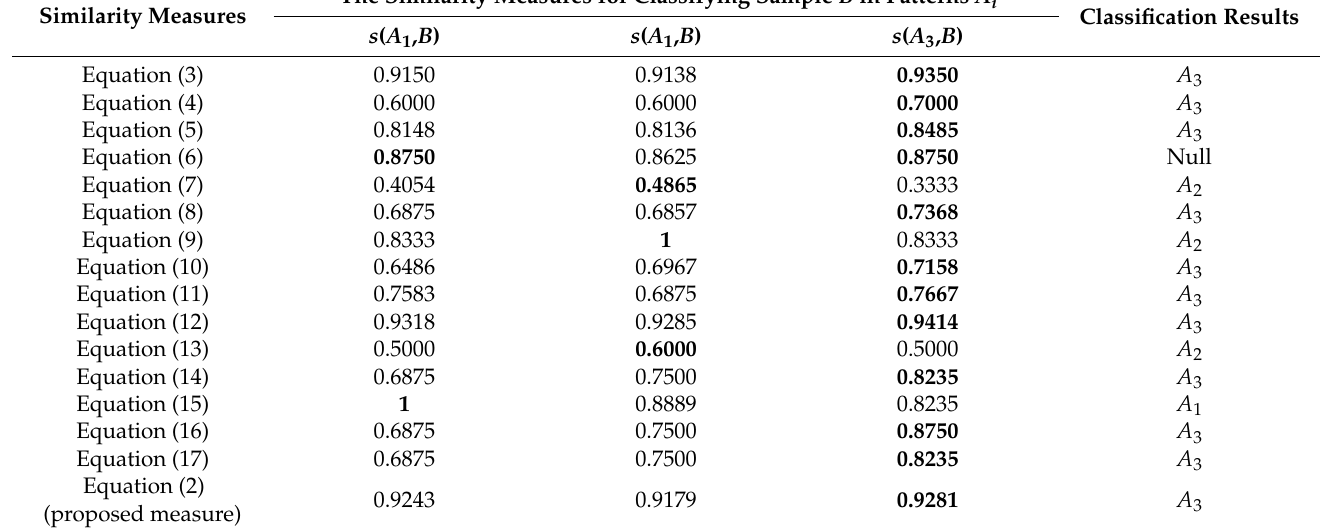
Table 2. Classification results for Example